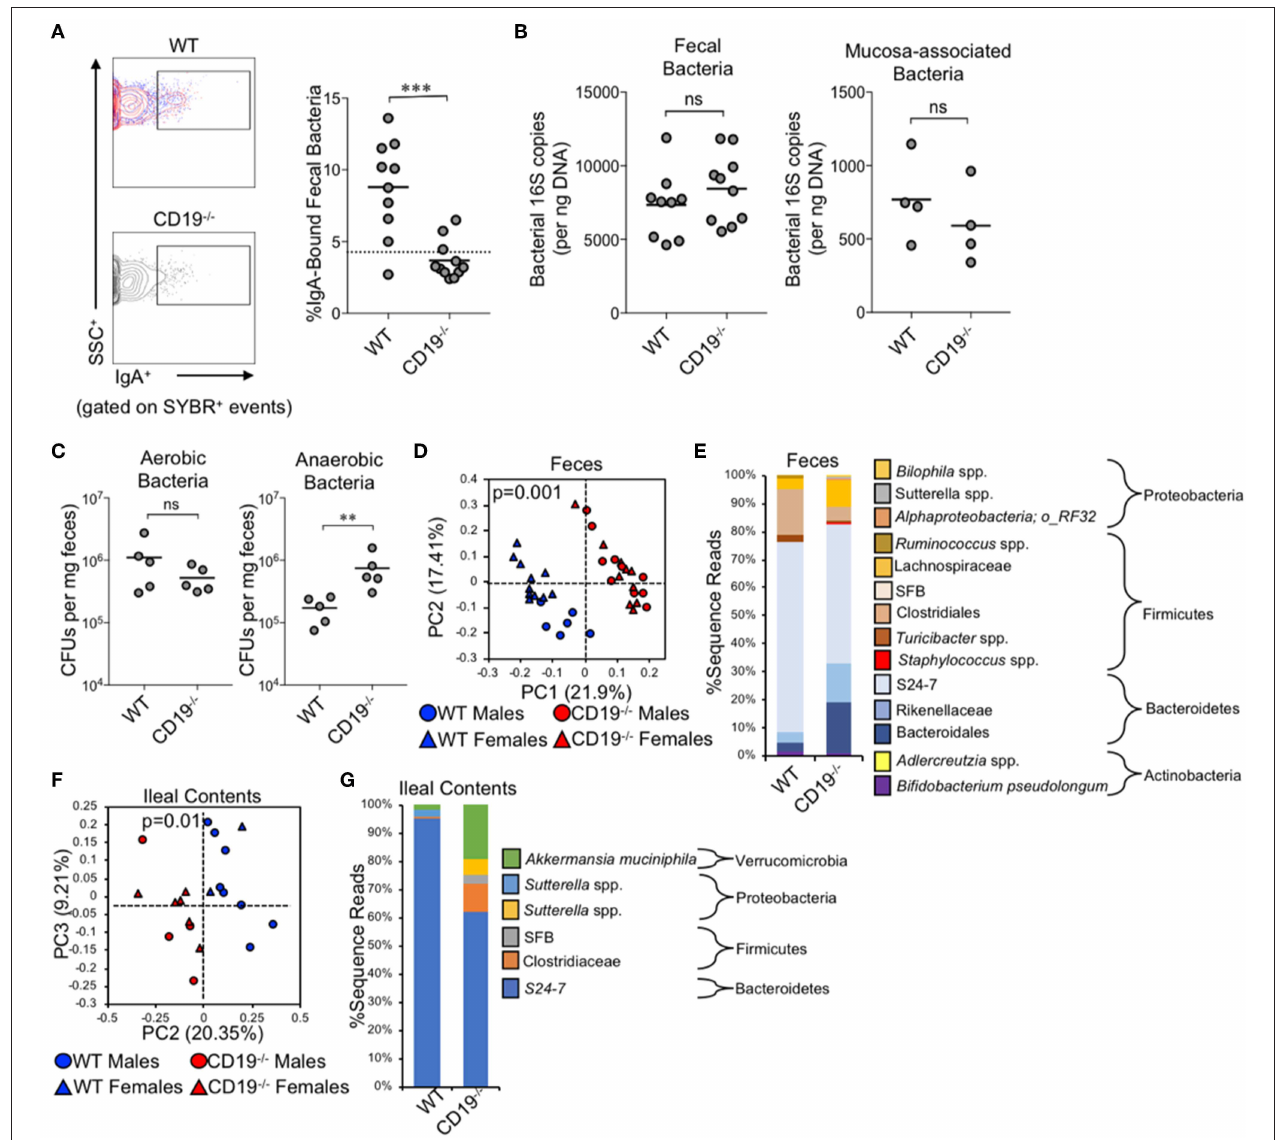
FIGURE 2 | CD19 − / − mice bind less commensal bacteria with IgA and have outgrowth of anaerobic bacteria. (A) A representative flow cytometry plot of IgA-bound bacteria gating is provided and the percentage of bacteria coated with IgA is shown. (B) The total abundance of fecal and mucosa-associated (small and large intestine) bacteria were quantified by qPCR. (C) The abundance of fecal anaerobic and aerobic CFUs were enumerated. (D) PcoA plot based on unweighted UniFrac analysis of β -diversity between WT and CD19 − / − fecal bacterial communities. (E) Stacked barplot summarizing fecal bacterial groups whose abundance is significantly altered in CD19 − / − mice. (F) PcoA plot based on Bray-Curtis analysis of β -diversity between WT and CD19 − / − ileal bacterial communities. (G) Stacked barplot summarizing ileal bacterial groups whose abundance is significantly altered in CD19 − / − mice. (A–C) Student’s t -test; ns, non-significant, ** = p < 0.01, *** = p < 0.001. (D,F) P -value represents result of PERMANOVA testing with 999 permutations. (E,G) Significant groups of differentially enriched bacteria were identified with discrete FDR testing.